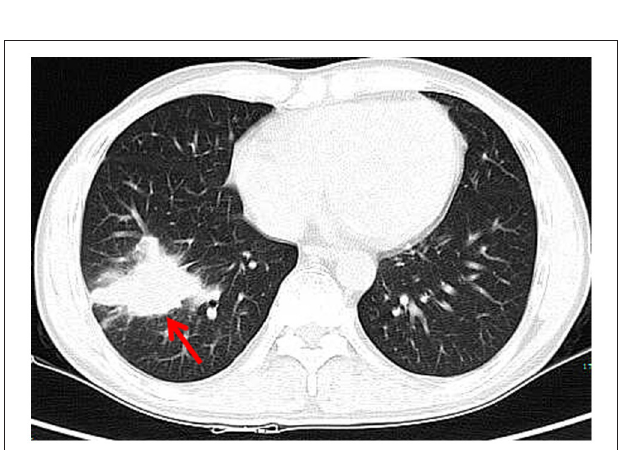
FIGURE 2 | Chest CT showed that the right lower lung mass had not shrunk after anti-infective treatment (red arrow).